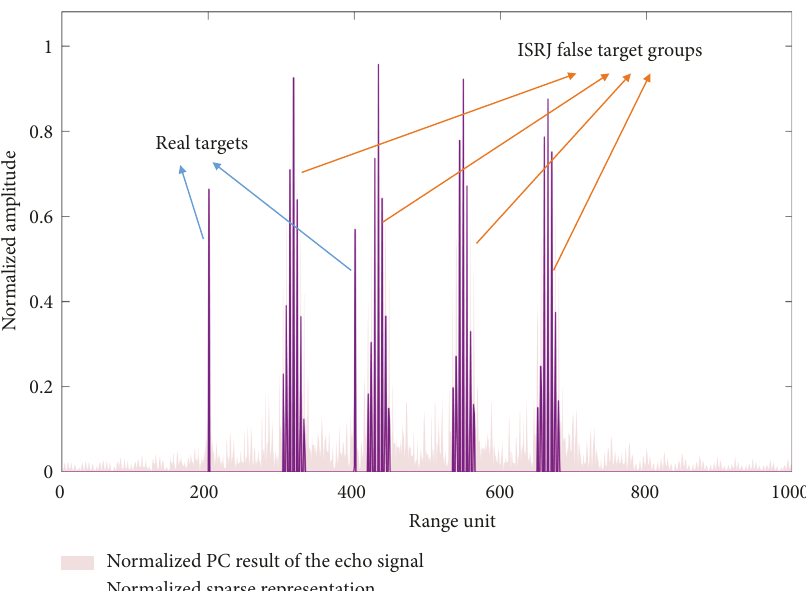
Figure 4: Sparse representation of the echo signal. The pink part shows the PC result of the echo signal and the purple line demonstrates the corresponding sparse representation result. In this case, the first real target carries the ISRJ jammer, and there are four false target groups, which means the forwarding time M �